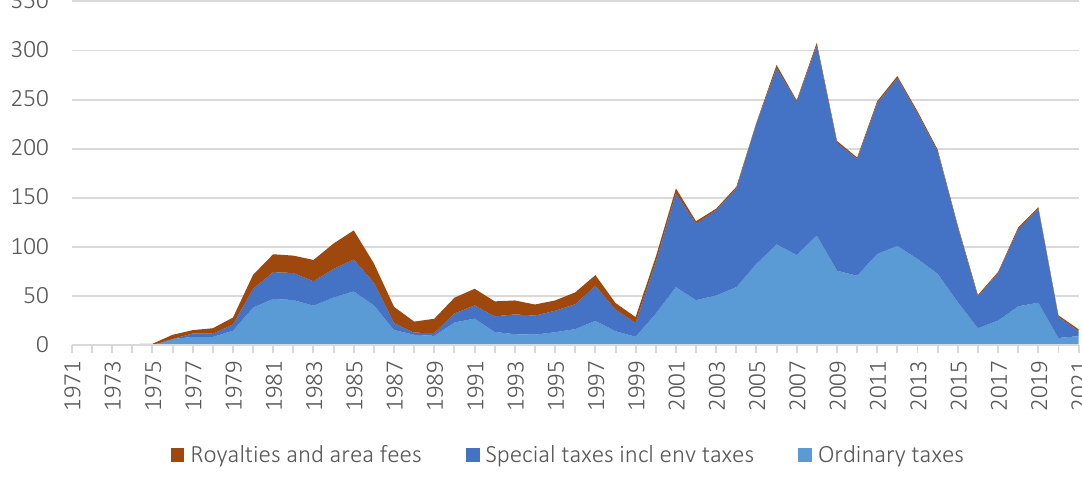
Figure 1. Taxes from oil and gas extractions in Norway 1971–2021, billion NOK 2021